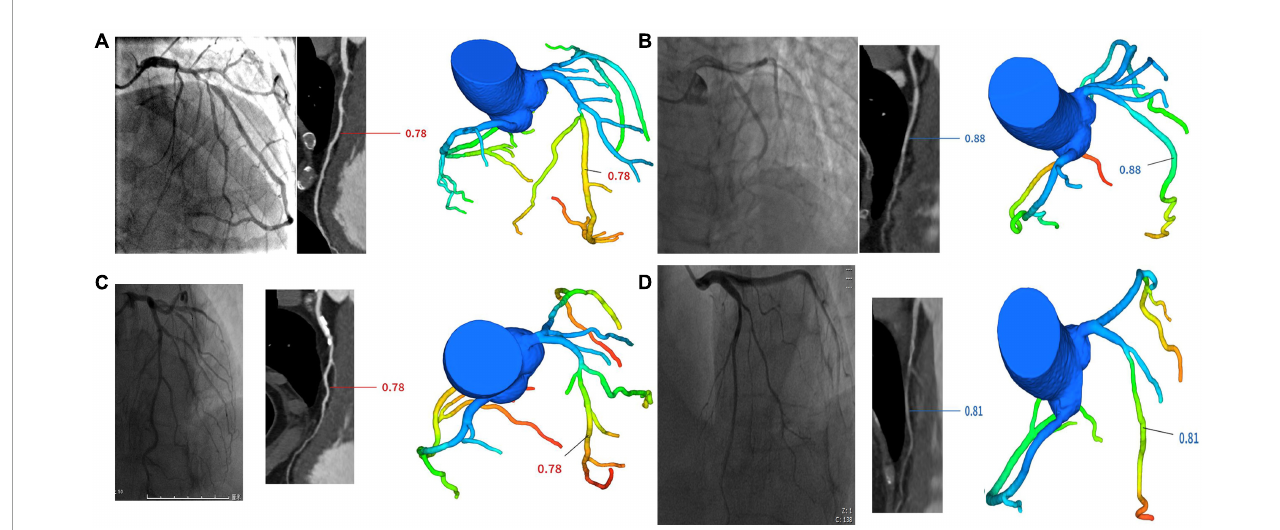
FIGURE1 Cases of four groups. (A) One case in IpFp group. ICA revealed proximal LAD stenosis 90% and FFRCT showed hemodynamic ischemia due to proximal segment stenosis (FFRCT = 0.78). (B) One case in IpFn group. ICA revealed proximal LAD stenosis 85% and FFRCT showed no hemodynamic ischemia (FFRCT = 0.88). (C) One case in InFp group. ICA revealed proximal LAD stenosis 70% and FFRCT showed hemodynamic ischemia (FFRCT = 0.78). (D) One case in InFn group. ICA revealed proximal LAD stenosis 60% and FFRCT showed no hemodynamic ischemia (FFRCT =